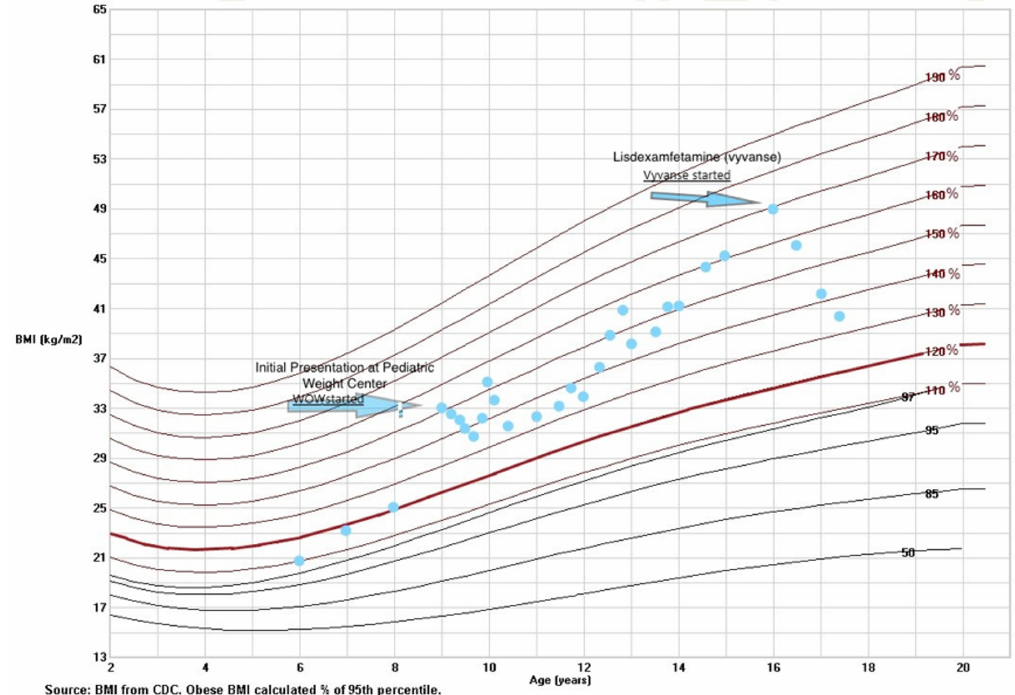
Figure 1. Body Mass Index (BMI) percentile growth curve for the patient in the case report at presentation (first arrow) and with treatment (second